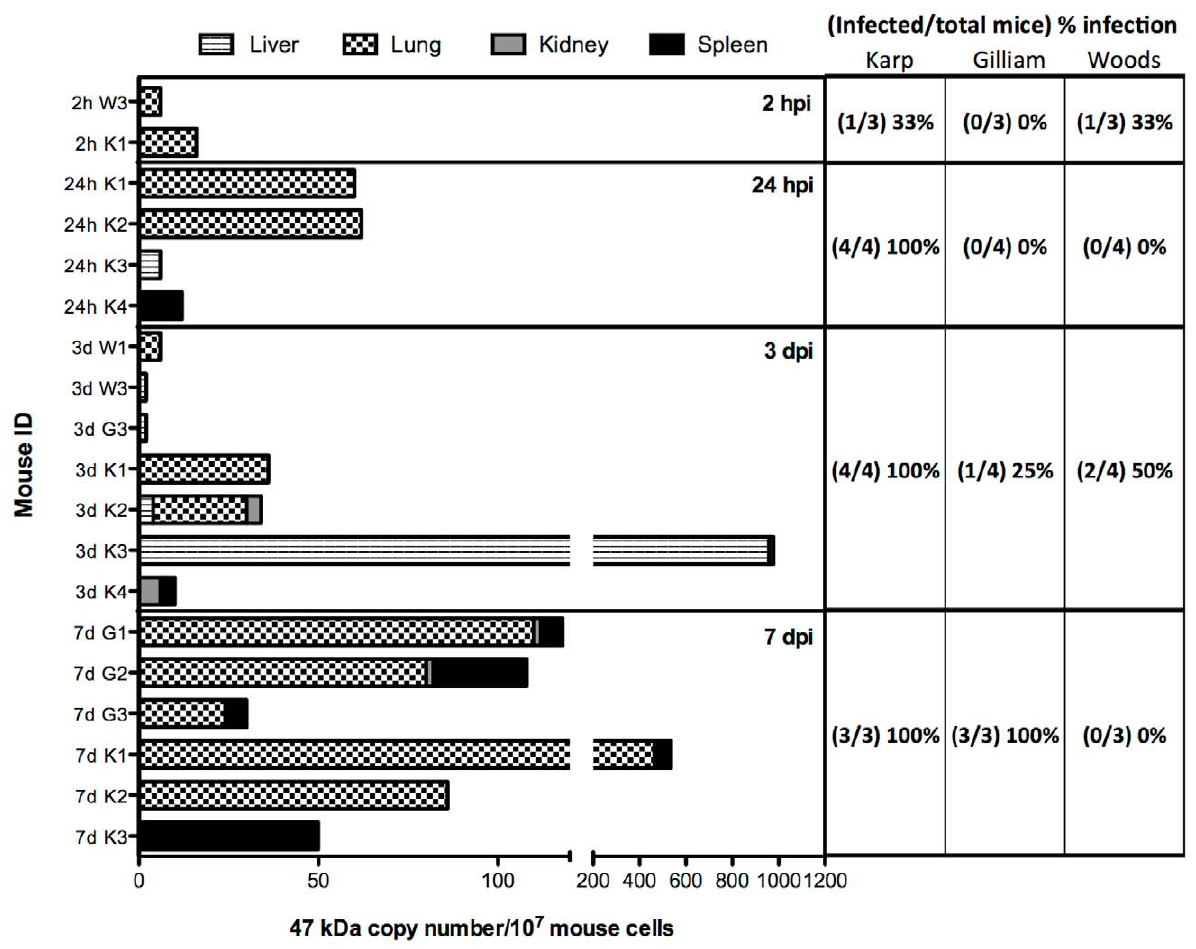
Figure 7. Bacterial load of O.tsutsugamushi in inoculated mouse tissues. O. tsutsugamushi copy numbers per 10 7 mouse cells in mouse tissues (liver, lung, kidney, and spleen) at 2 hpi, 24 hpi, day 3 pi, and day 7 pi were quantitated using an Orientia -specific 47 kDa qPCR assay. The percentage of O. tsutsugamushi infected mice at each time point is shown in table. Abbreviations used: Karp (K), Gilliam (G), and Woods (W).